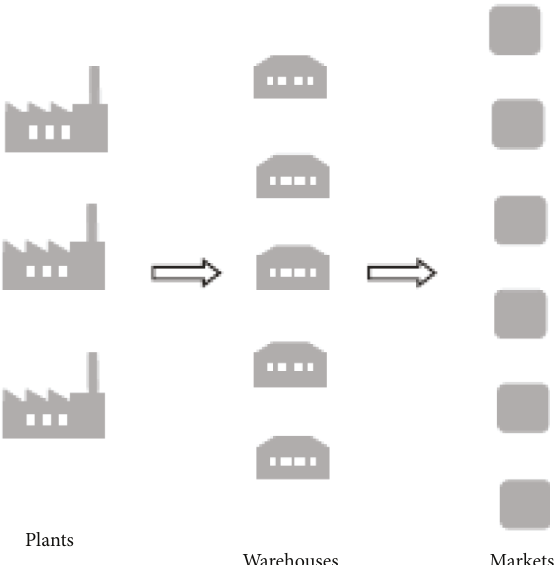
Figure 2: The structure of the supply chain considered by this